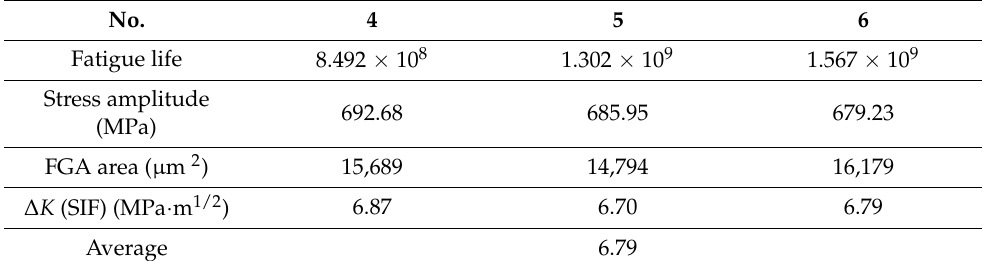
Figure 12. ∆ K of specimen with surface and internal crack (RA). Table 3. ∆ K value of cracks initiating from surface and internal defects